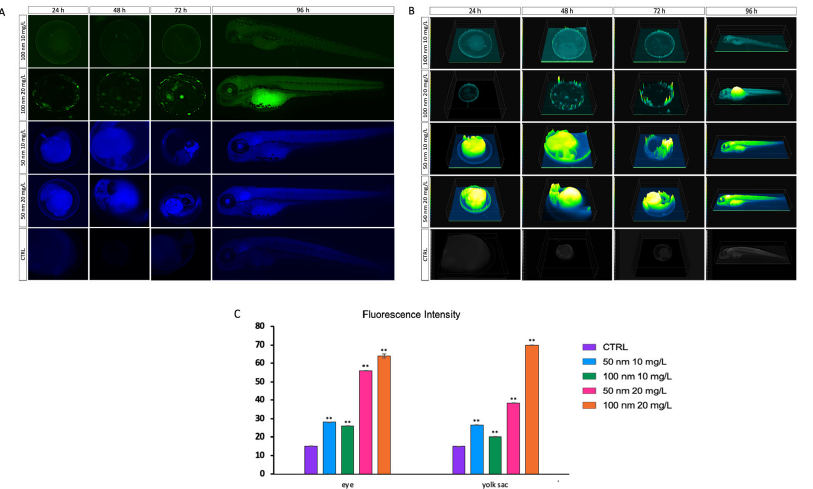
Figure 1. ( A ) Accumulation and biodistribution of PS-NPs (50 and 100 nm) at different concentrations in D. rerio embryos and larvae. The observations were carried out in 24 h intervals; ( B ) surface fluorescence intensity plot obtained by analyzing the images of biodistribution of PS-NPs (50 and 100 nm) at different concentrations in D. rerio embryos and larvae; ( C ) fluorescence intensity calculated on the ROIs considered (eye and yolk sac) at 96 hpf. Strong statistical differences were found between control groups and all organisms exposed ( p < 0.01 **).